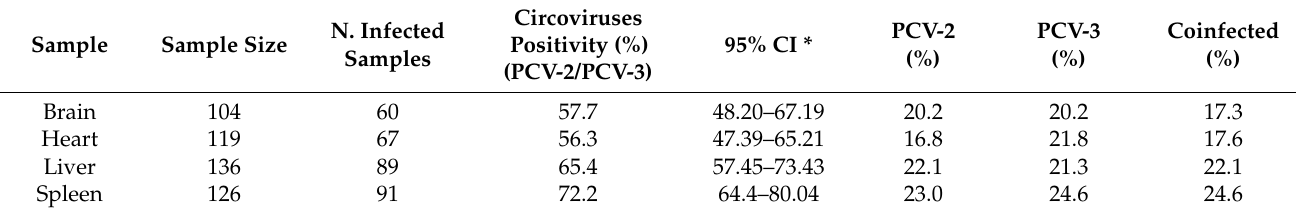
Table 3. Numbers of tissue sample tested and their percentages of positives to porcine circoviruses.